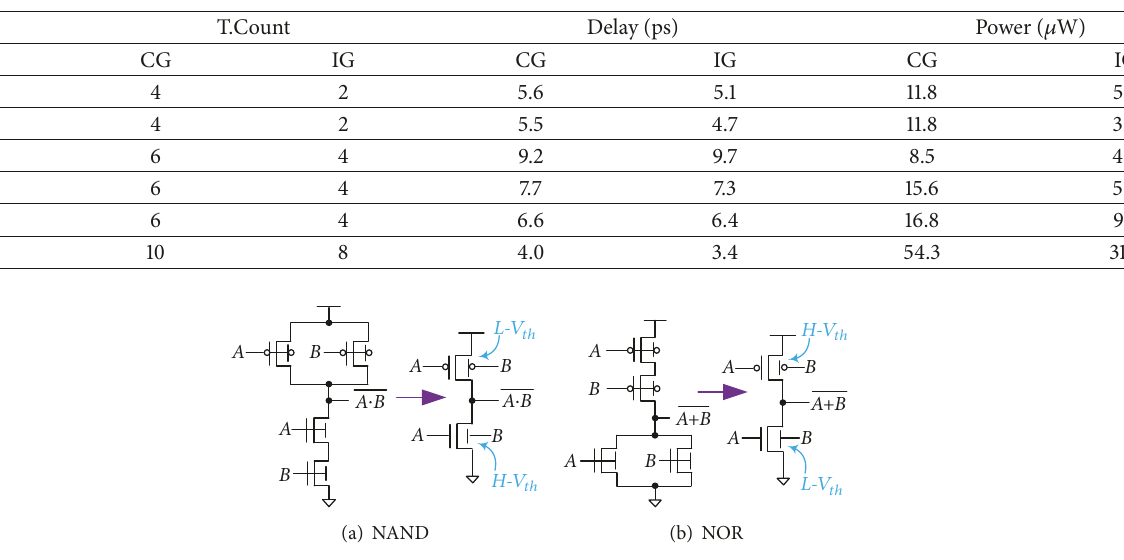
Figure 1: The basic logic cells realized by the CG FinFETs and DTIG FinFETs, respectively. (a) NAND, (b)